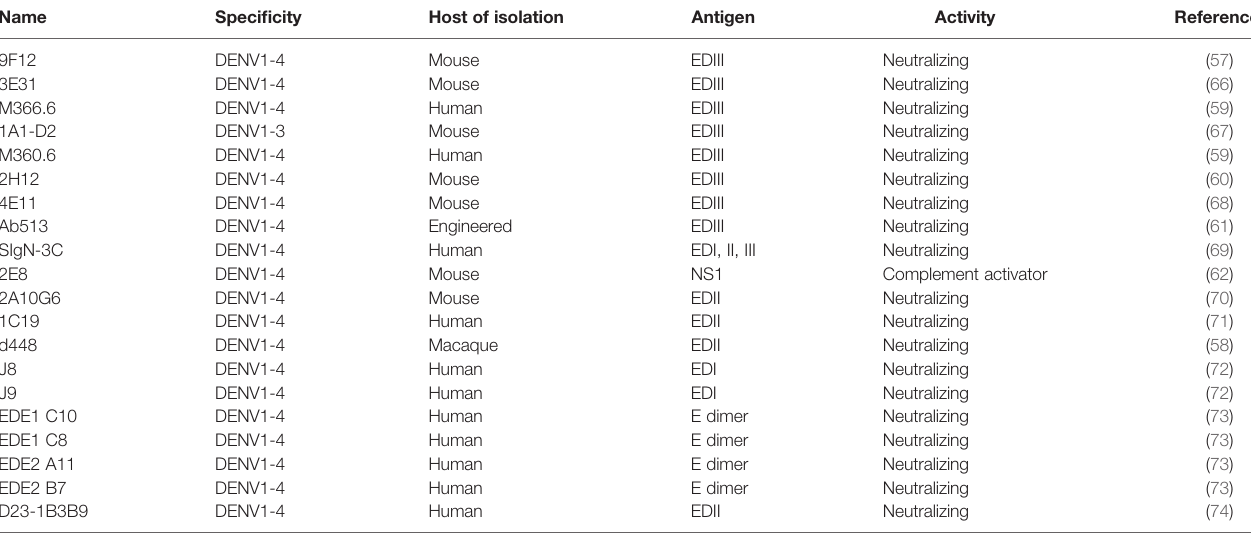
TABLE 2 | Dengue mAbs reported in literature and main